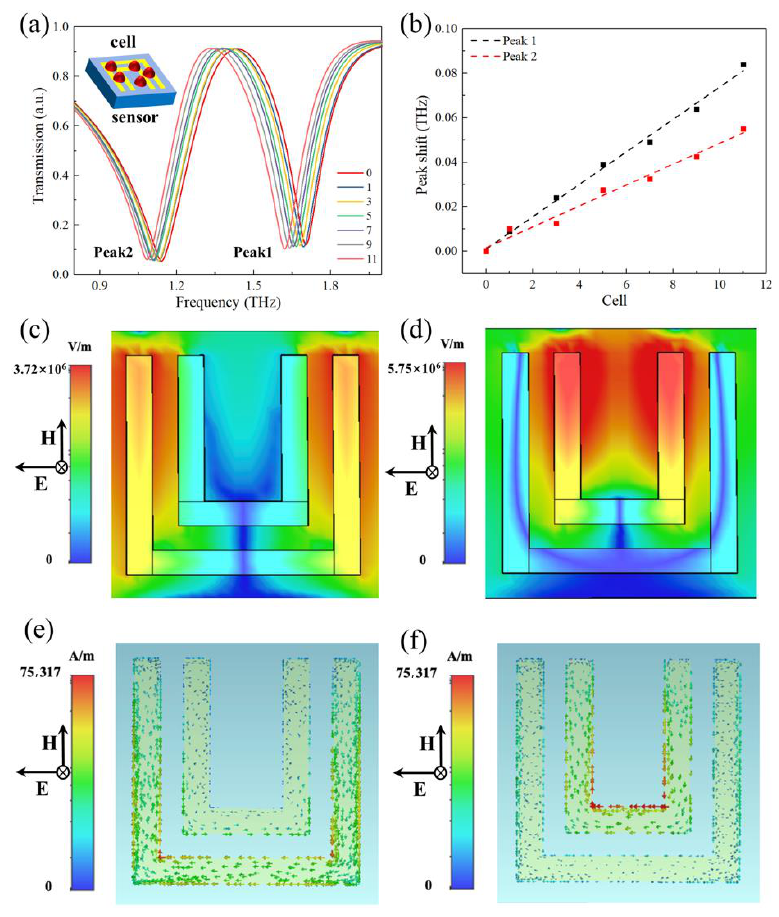
Figure 3. The simulated results of the metamaterial biosensor. ( a ) The transmission spectra of metamaterial with different numbers of cells on the surface. The inner graph shows the schematic illustration of the simulation; ( b ) the peak shift of the two peaks with different numbers of cells. ( c ) Electric field distribution in the X-Y plane at peak 2. ( d ) Electric field distribution in the X-Y plane at peak 1. ( e ) Surface current distribution in the X-Y plane at peak 2. ( f ) Surface current distribution in the X-Y plane at peak